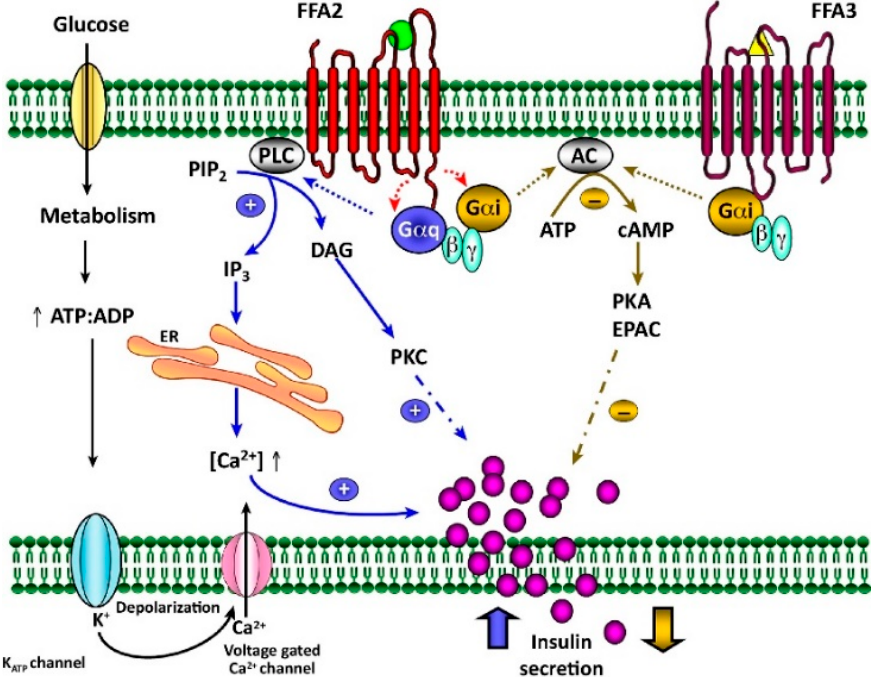
Figure 1. Regulation of insulin secretion by short-chain fatty acids (SCFAs) through receptors FFA2 and FFA3. SCFAs can bind to both receptors either amplifying (in blue) or diminishing (in